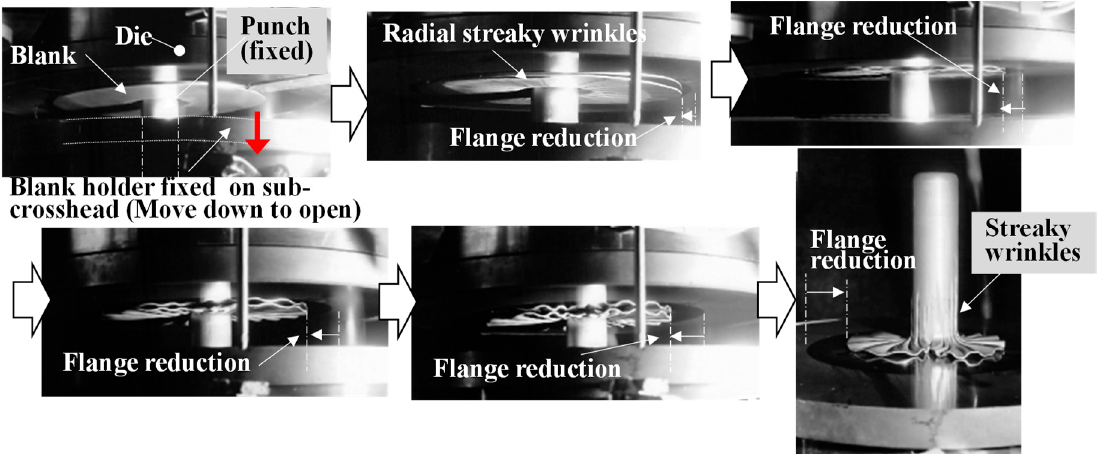
Figure 3. A sequential photograph of the occurrence and growth of wrinkles on the flange part under the conditions of constant punch speed (SPD) and blank holder force (BHF) in a warm deep drawing process using a large blank with a drawing ratio (DR) = 5.